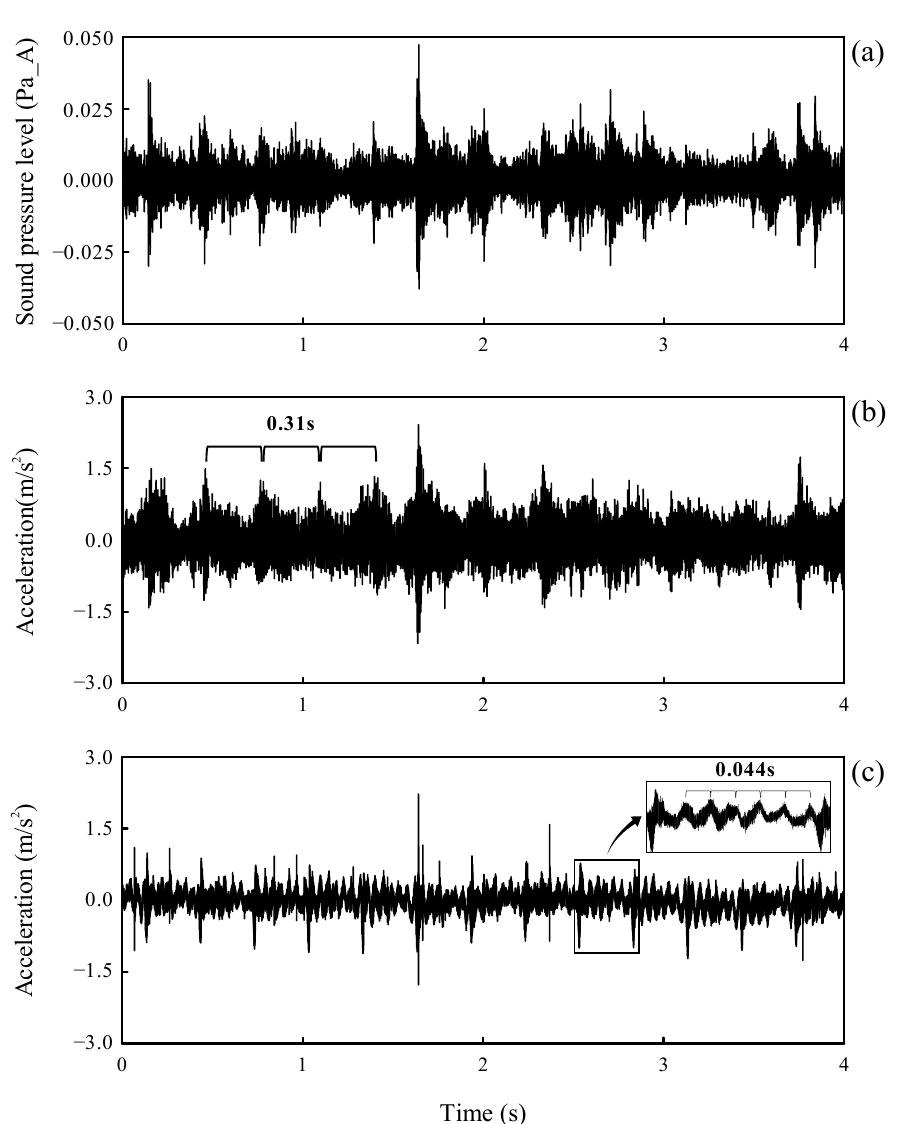
Figure 3. Time responses for the noise and vibration of the assembled wheel bearing: ( a ) noise, ( b ) vibration of the dust shield, and ( c ) vibration of the outer ring.